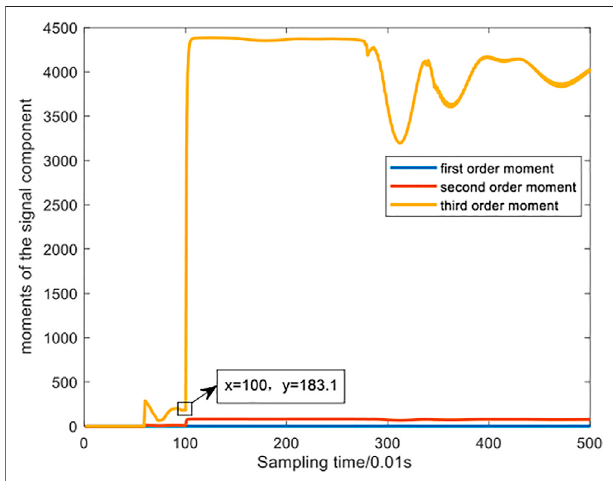
FIGURE 9 | Moments of the signal component in case